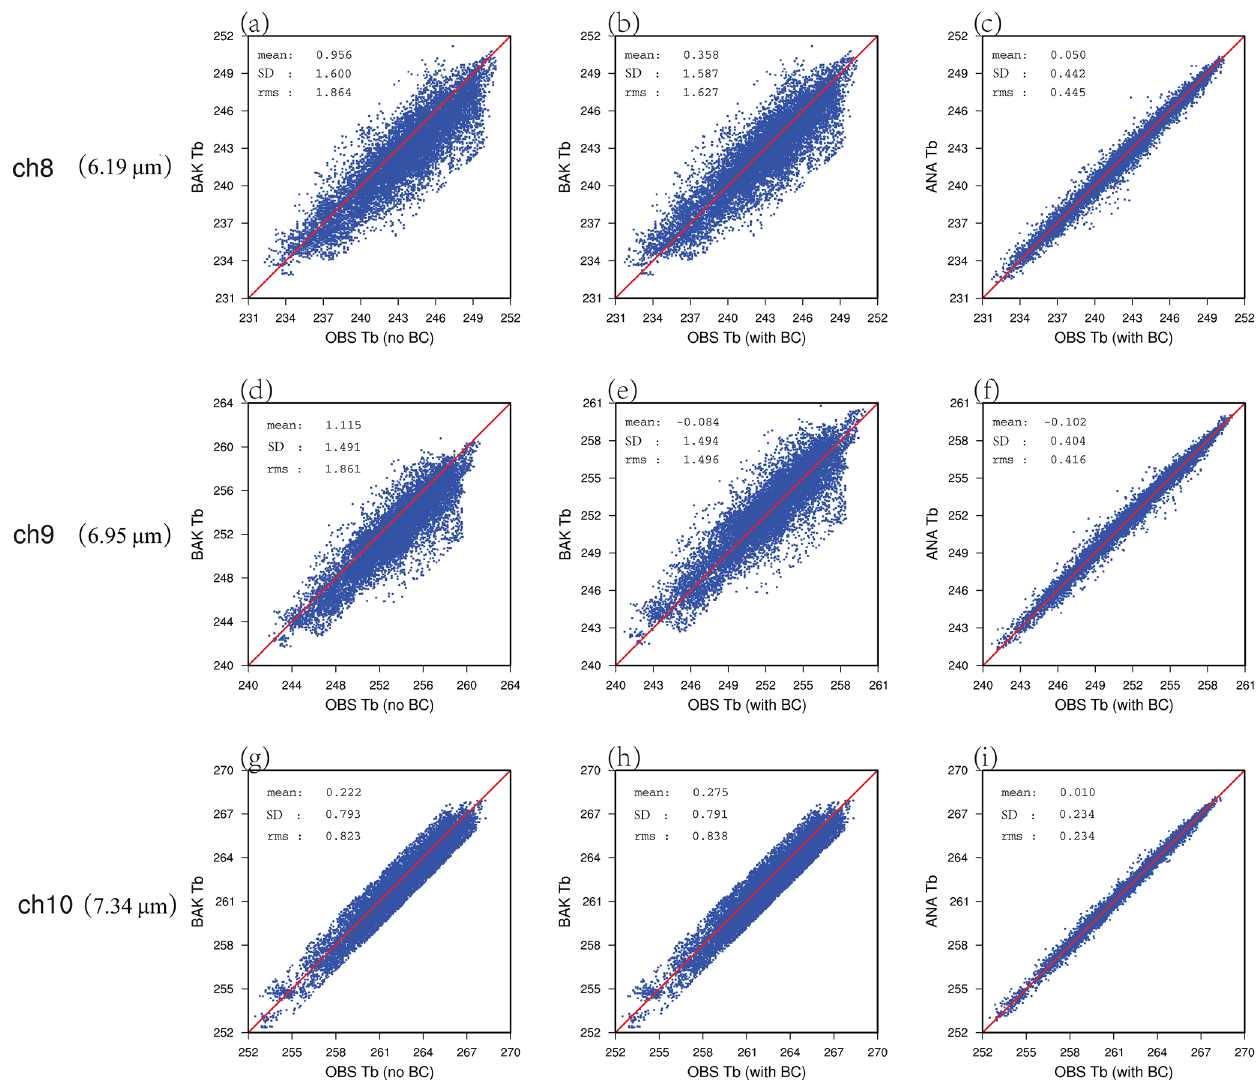
Figure 8. Scatterplots of (a, d, g) the observed and background brightness temperature before the bias correction of channels 8–10. Scatter- plots of (b, e, h) the observed and background brightness temperature after the bias correction of channels 8–10. Scatterplots of (c, f, i) the observed and analyzed brightness temperature after the bias correction of channels